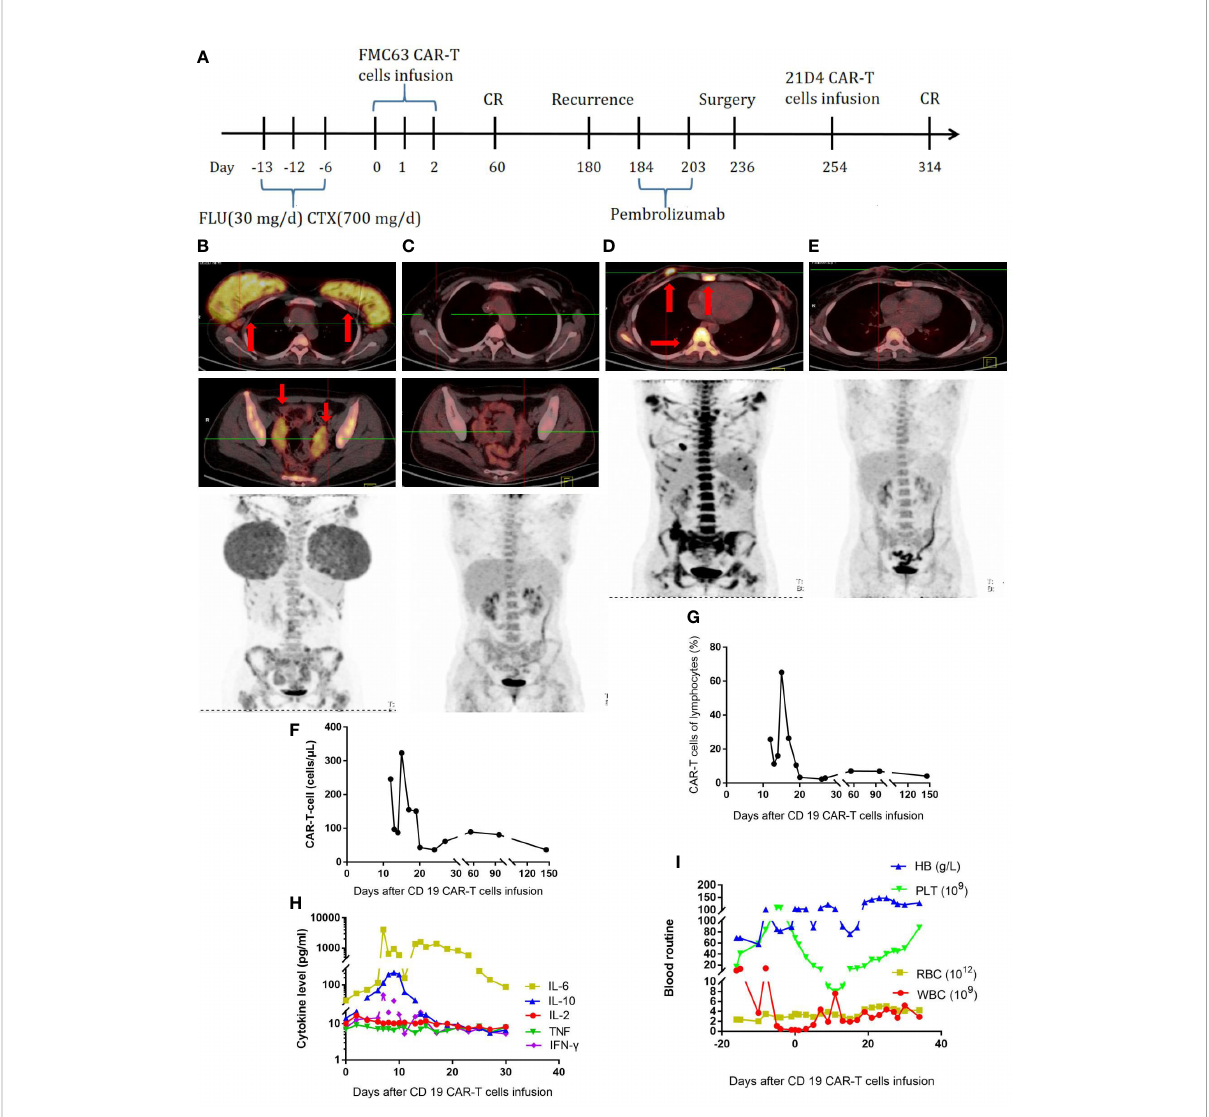
FIGURE 2 (A) , Timeline of the treatment process. (B) , PET-CT before the fi rst CAR-T-cell treatment. (C) , PET-CT two months after the fi rst CAR-T-cell treatment. (D) , PET-CT at the half a year after the fi rst CAR-T-cell treatment and relapse. (E) , PET-CT two months after the second CAR-T-cell treatment. (F) , CAR-T-cell expansion after CAR-T-cell infusion. (G) , Percentage of CAR-T cells in lymphocytes after CAR-T-cell infusion. (H) , Cytokine levels after CAR-T-cell infusion. (I) , Routine blood